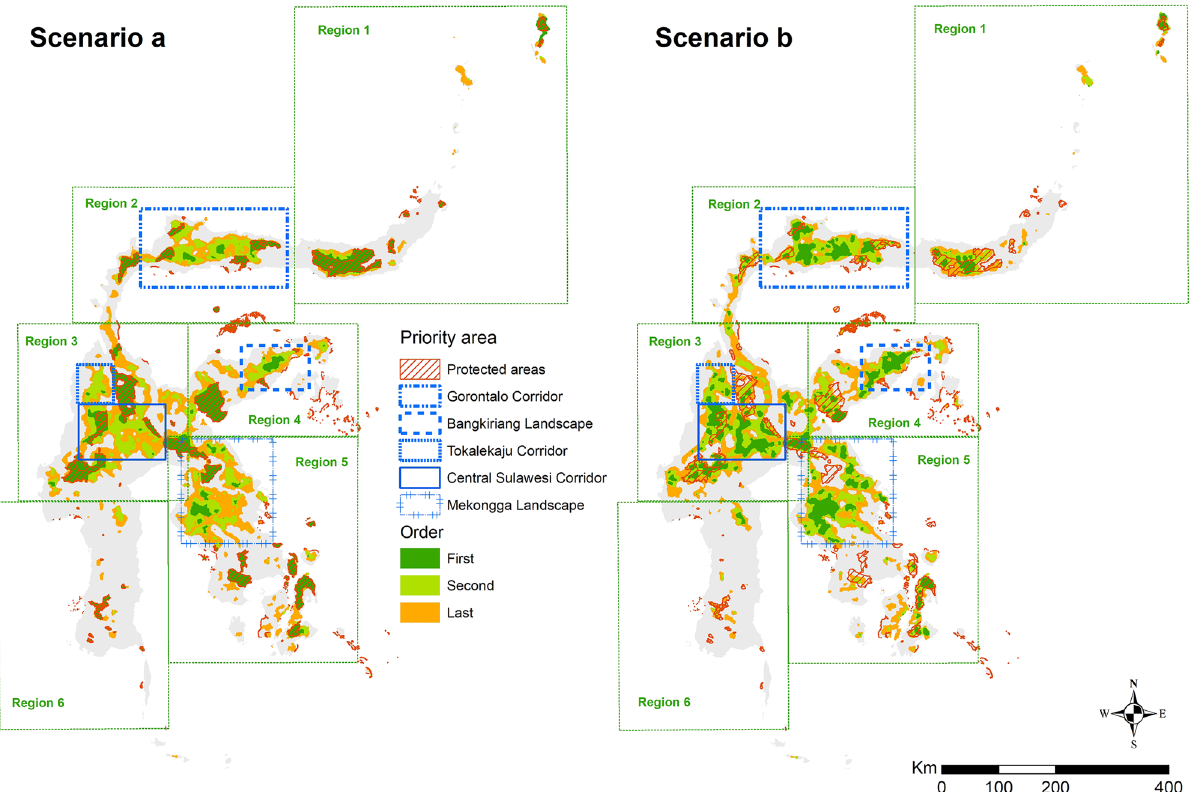
Figure 5. Priority areas in Sulawesi based on scenarios ‘a’ (in which the current PA network had to be included in the selection) and ‘b’ (in which any area could be selected), as well as the proposed order of selection for protecting these